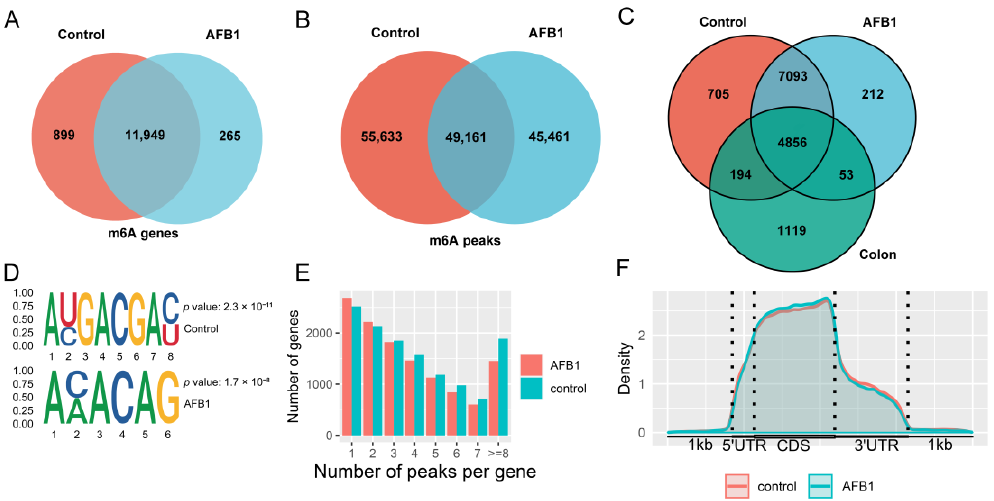
Figure 2. Venn diagram showing the ( A ) m6A genes and ( B ) peaks; ( C ) Venn diagram showing the m6A genes from the HCT116 control group, AFB1 group, and the healthy human colon data obtained by m6A-TSHub; ( D ) the motifs enriched from identified m6A peaks based on STREME; ( E ) the m6A-modified peaks number in genes; ( F ) the density of m6A-modified peaks in mRNA transcripts.